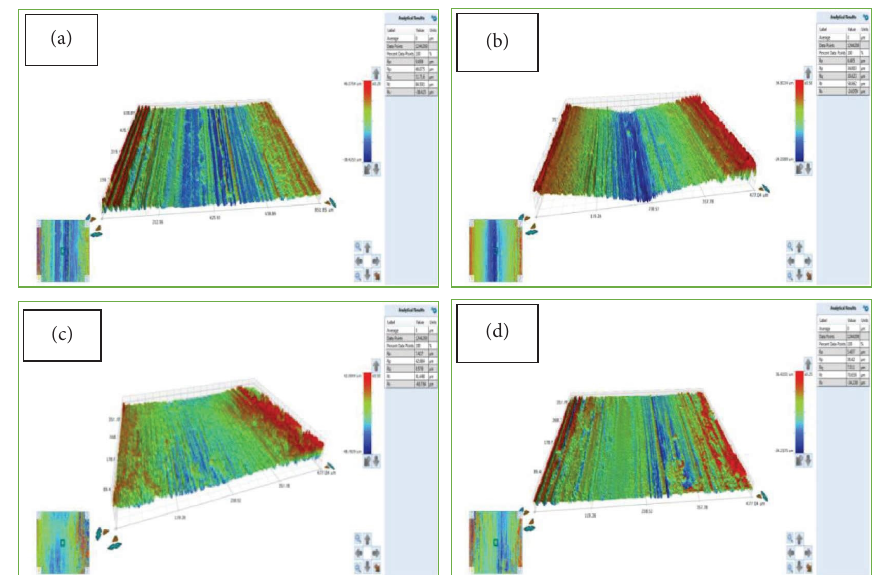
Figure 15: 3D proflometer image of HAlSi24 alloy under lubricated condition at (a) 20N, (b) 30N, (c) 40 N, and (d)